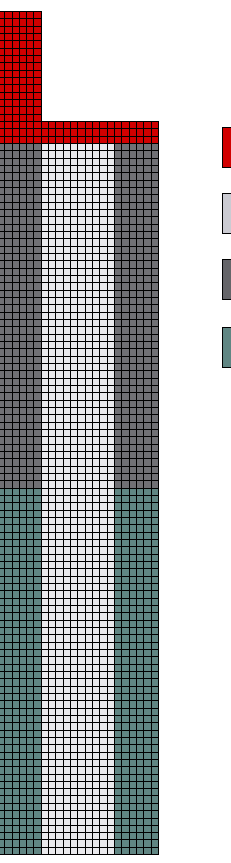
Figure 10. RBSM discretization and materials.